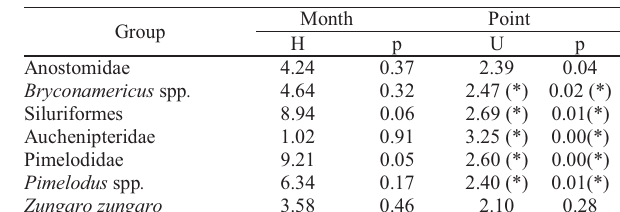
Table 2. Results of the Kruskall-Wallis (H) and Mann-Whitney (U) tests applied to the most abundant taxonomic groups captured in the headwaters of the Cuiabá River between November 2007 and March 2008. (*) indicates significant differences (p<0.025, corrected by Bonferroni’s Correction).